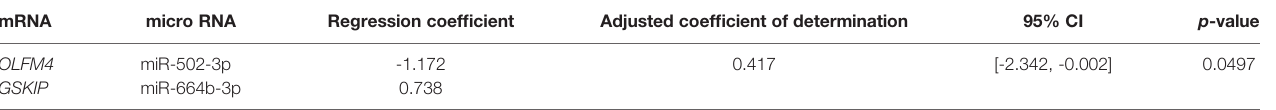
TABLE 2-B | Simple regression analysis between micro RNA and mRNA in intramucosal cancer in validation cohort (cohort 2). mRNA micro RNA